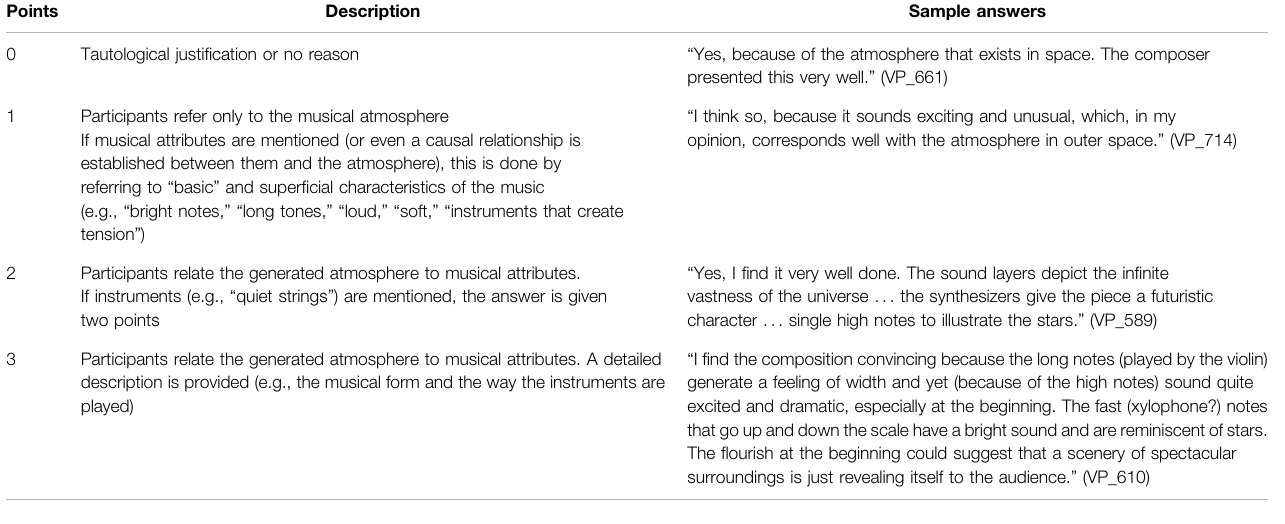
TABLE 1 | Coding scheme for the sample item “ Star Wars ” (condensed and simpli fi ed version). Points